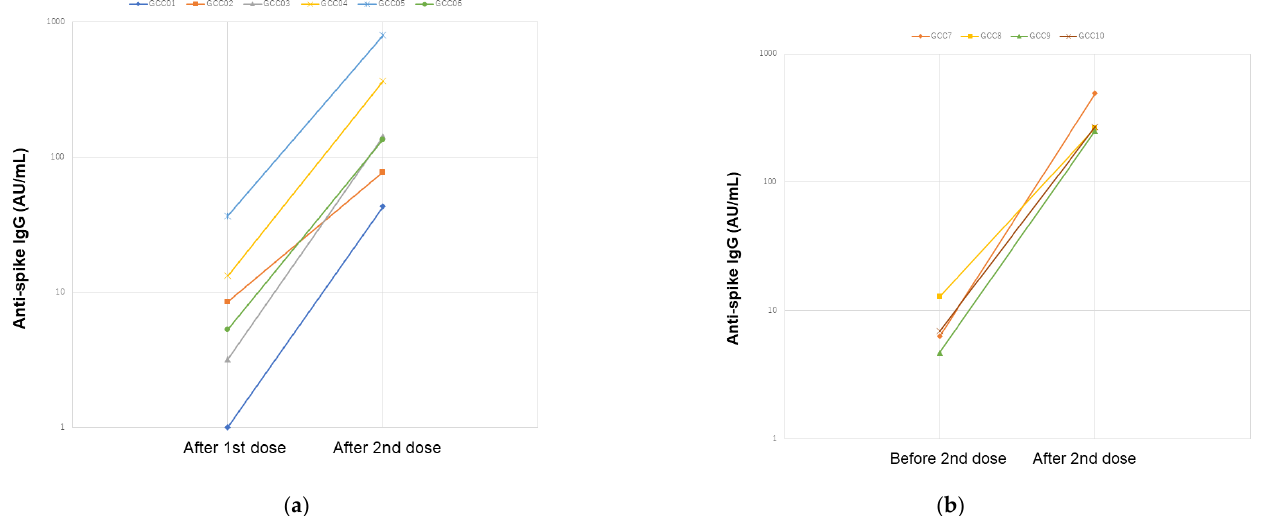
Figure 1. Time course of SARS-CoV-2 anti-spike immunoglobulin G (IgG) response before and after the second dose of BNT162b vaccine. Each line represents a single participant. ( a ) Time course of anti-spike IgG response of the six participants who received the second dose of vaccine three weeks after the first dose. ( b ) Time course of anti-spike IgG response of the four participants who experienced an acute allergic-like reaction to the first dose of vaccine and received a second dose six months after the first dose. The six participants who received the second dose of vaccine three weeks after the first dose had their anti-spike IgG measured three weeks after the administration of first dose of vaccine, before receiving the second dose.